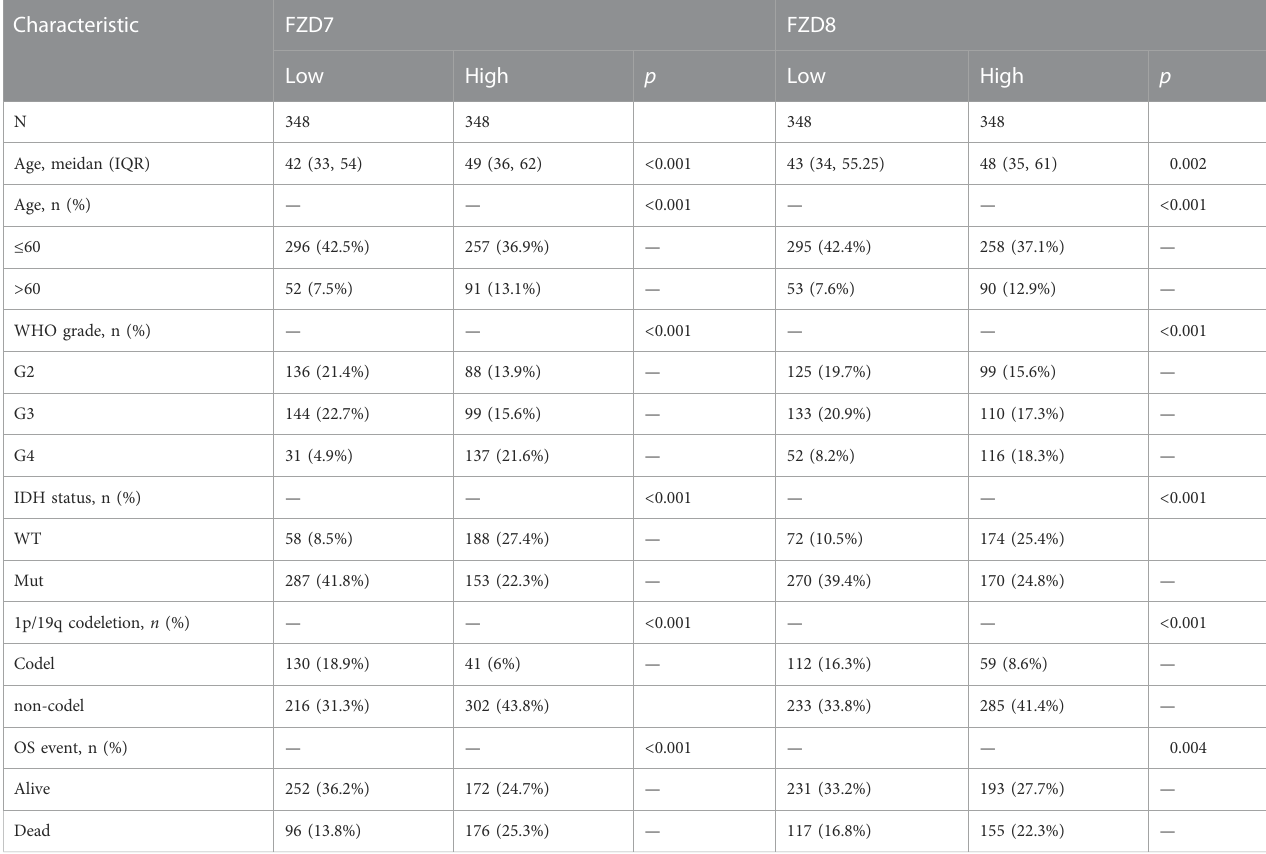
TABLE 3 The FZDs expressions in glioma patients with different clinical parameters.